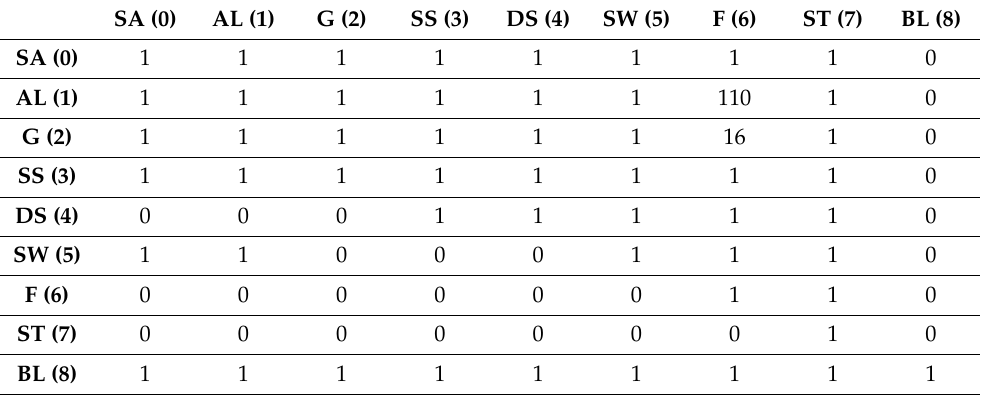
Table 3. Matrix of permissible transformations of the landscape of M. of Mouzaki (SA = Silvoarable, G = Grassland, AL = Agricultural land, SS = Sparse Shrubland, DS = Dense Shrubland, SW = Silvopastoral Woodland, F = Forest, ST = Settlements and BL = Barren